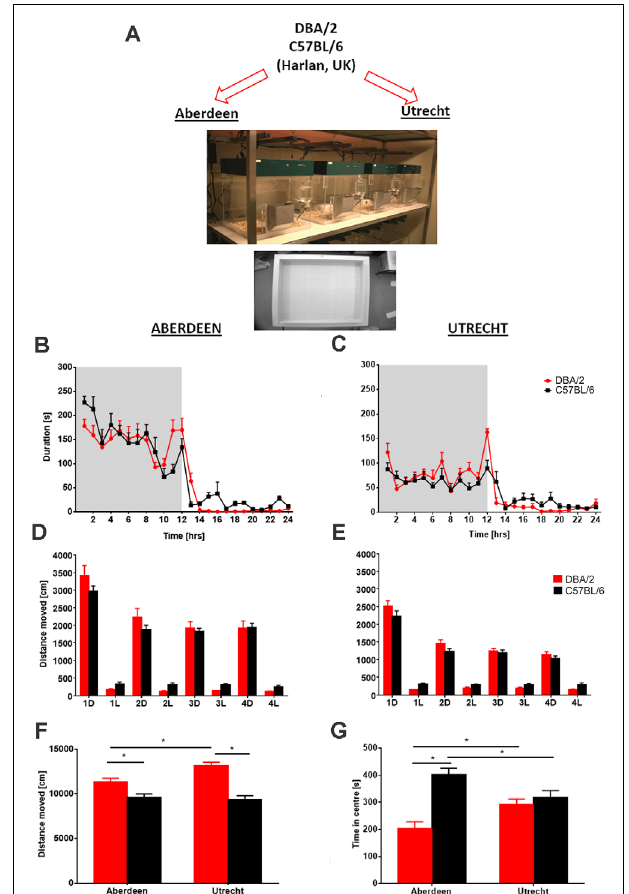
FIGURE 2 | Between laboratory analysis of ambulatory activity and anxiety-related behavior in two different mouse strains. (A) Following delivery of mice to the two behavioral facilities in Aberdeen and Utrecht, identical experiments were conducted using the home cage observation system PhenoTyper and the open field. Circadian activity (hourly bins) expressed as time spent in the open area of the PhenoTyper during a 24-h period (shaded area = dark phase of testing) revealed that activity of both mouse strains DBA/2 and C57BL/6 in Aberdeen (B) and Utrecht (C) laboratories was increased during periods of darkness and declined during the light phase. Despite overall higher ambulatory activity in the Aberdeen mice, similar activity peaks at the beginning and end of the dark phase were obtained with both strains in both laboratories. Analysis of distance moved across four consecutive recording days averaged for 12-h time bins, dark (D) and light (L) phases of activity revealed no overall significant differences between strains in both (D) Aberdeen and (E) Utrecht, although similar trends were observed across laboratories with DBA/2 mice being more active during the dark phases and C57BL/6 more active during the light phases. Following completion of PhenoTyper testing analysis of activity (distance moved) (F) and anxiety-related (time spent in the center) in the open field (G) revealed activity differences between the two strains that were comparable across both laboratories, with DBA/2 mice displaying higher levels of activity than C57BL/6 mice. However, a difference in anxiety-related behavior between the two strains was only observed in Aberdeen with DBA/2 displaying heightened levels of anxiety-like behavior (i.e., less time spent in the center) compared to C57BL/6. Furthermore, some strain differences were observed between laboratories with C57BL/6 mice being less anxious in Aberdeen compared to Utrecht with the opposite observed for DBA/2. Data are presented as means + SEM. Asterisks denote p < 0.05, t -test. The figure is adapted from Robinson et al.